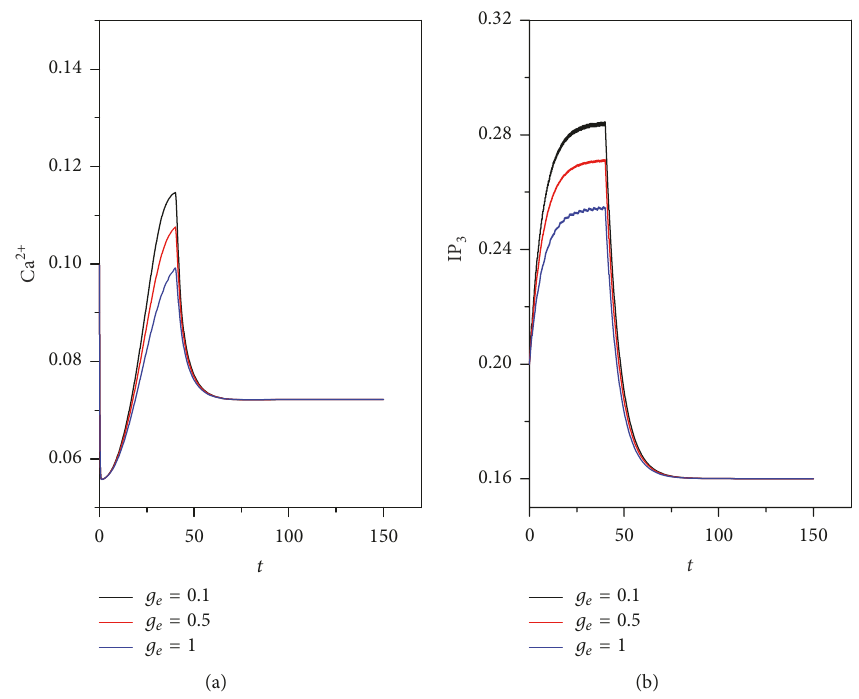
Figure 5: Fluctuation in Ca 2+ concentration and IP 3 concentration is calculated by applying different feedback gains 𝑔 𝑒 in autapse with time = 0.2 . And the external forcing current regulates the neuron by setting 𝐼 delay 𝜏 = 2 . The parameter is set as 𝑟 IP 3 𝑡 < 40